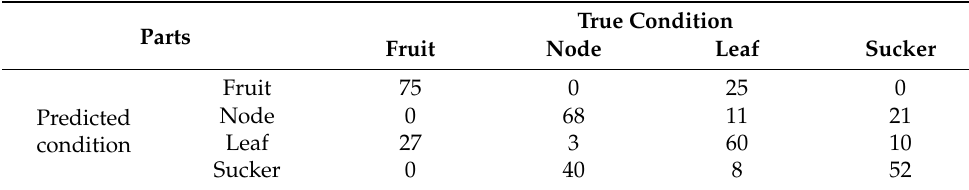
Table 5. Results of SVM classifier using RBF kernel.